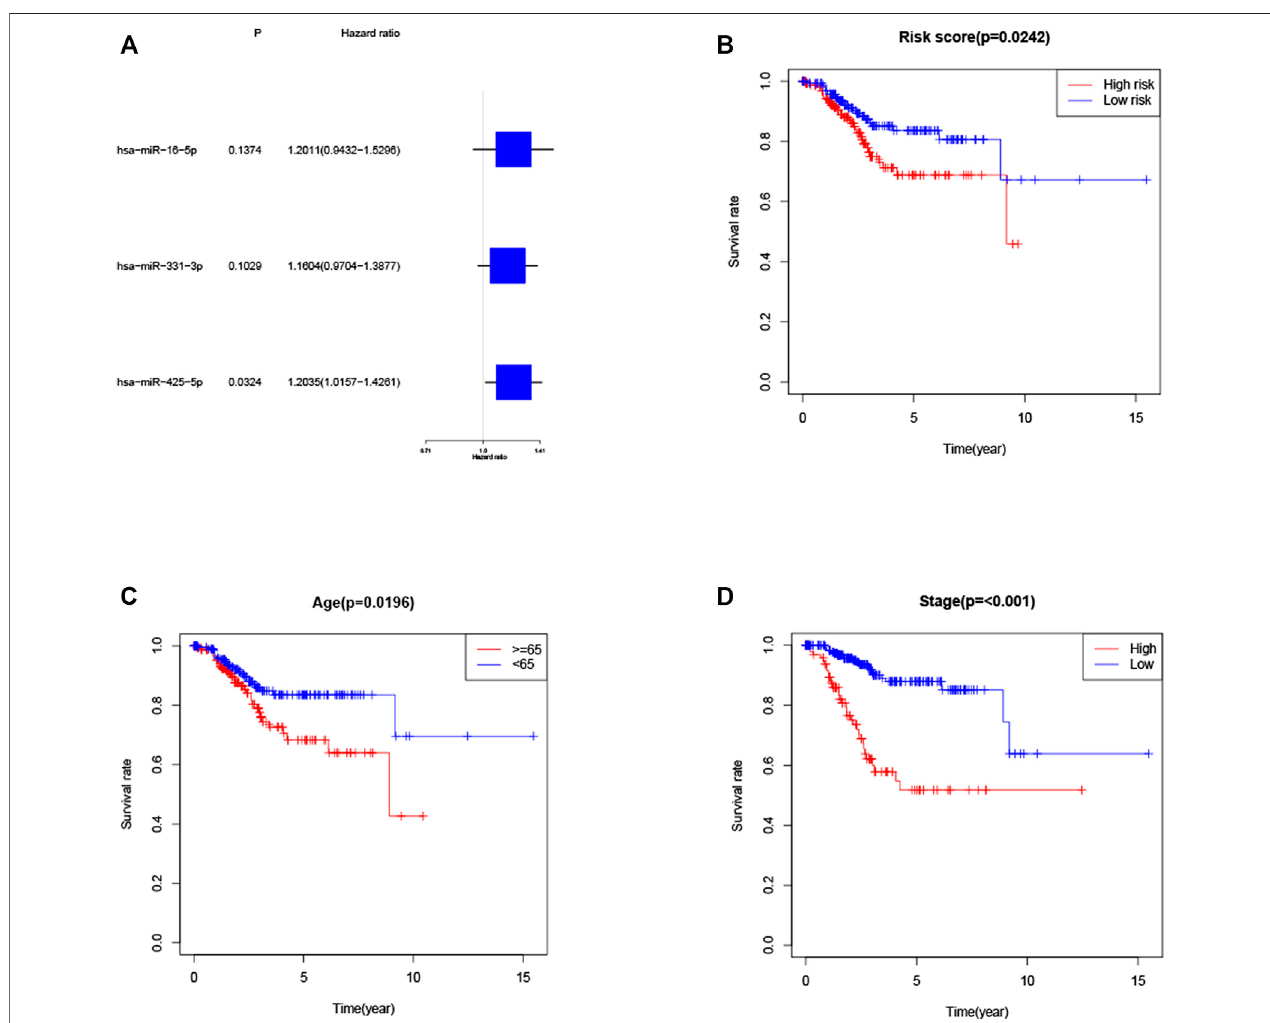
FIGURE 3 | Construction of the risk score model. (A) Univariate cox regression analysis of OS for three DENSMs in TCGA cohort. (B) Kaplan – Meier curves for the OS of patients in the high- and low-risk groups in training cohort. (C) Kaplan – Meier curves for the OS of patients in the high- and low-age groups in training cohort. (D) Kaplan – Meier curves for the OS of patients in the high- and low-stage groups in training cohort.